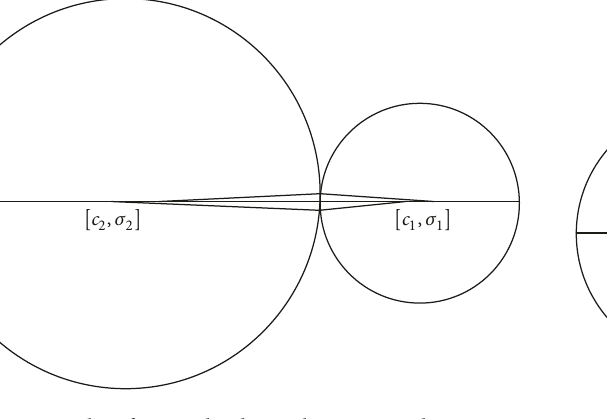
Figure 5: Circles of unequal radii touching at a single point.